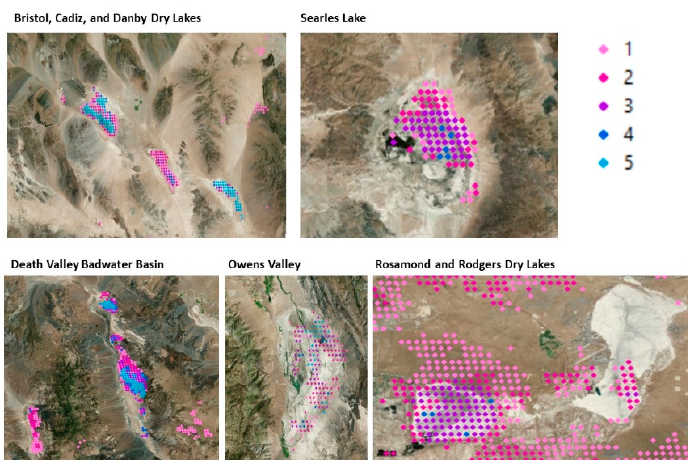
Figure 3. Breakpoints detected in selected dry lakes (as true-color images) within the study region from structural change analysis of LST between 2000 and 2018 for the MODIS 1-km monthly time series. Number of breakpoints per pixel shown in the color legend (upper right). All maps are upward in the northern direction.